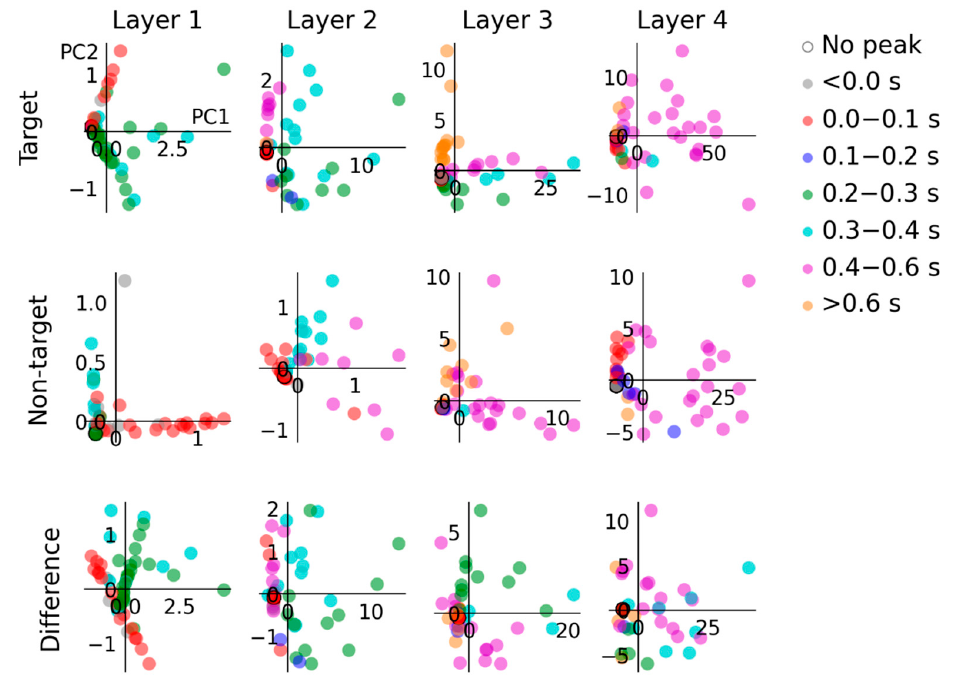
Figure 5. PCA highlights different sources of model variance in response to target and non-target input conditions. In layer 1, the target condition exhibits a dominant source of variance from units that peak from 0.2 to 0.3 s and 0.3 to 0.4 s, whereas the main source of variance in responses to the non-target condition are due to units that peak from 0 to 0.1 s. In layer 2, variance in the target condition is mainly due to units peaking from 0.2 to 0.3 s, 0.3 to 0.4 s and 0.4 to 0.6 s; in contrast, the non-target condition variance primarily arises due to units peaking from 0.3 to 0.4 s and 0.4 to 0.6 s. In layer 3, model responses to both conditions are similarly influenced by units peaking >0.6 s. In layer 4, the units that contribute directly to the model output show a similar pattern of principal components in response to target and non-target inputs. The main sources of variance are due to units that peak from 0.4 to 0.6 s. Peak amplitudes or other measurements from hidden unit activations can be evalu- ated using statistical methods. Two approaches for comparing peak amplitudes are taken here: (i) by latency range–layer pairs containing more than two units for both target and non-target conditions, and (ii) by latency range across all layers. Independent t-tests with Bonferroni–Holm corrections were performed to establish whether differences between hidden unit peak amplitudes in response to target and non-target inputs were statistically significant, with an alpha of 0.05. 3. Results 3.1. Cross-Validation Performance Outputs from models trained during five-fold cross-validation are plotted in Figure 2. In each fold, a ‘new’ RNN was initialized and optimized to replicate the grand-average ERPs of its training labels. Thereafter, two validation ERPs (one target and one non-target event) left out from the training dataset were compared with the outputs generated by the trained model. This was repeated five times using a different pair of target and non-target validation ERPs, as described above. Over the five folds, model outputs and cross-valida- tion ERPs were highly correlated (all r 2 > 0.97). This approach is consistent with some of the core principles of ERP analysis, as events are grouped into distinct categories, and the average waveform produced by these events reflects a stereotypic brain response. Thus, training the model to reproduce the grand-average of a sample of training ERPs and then